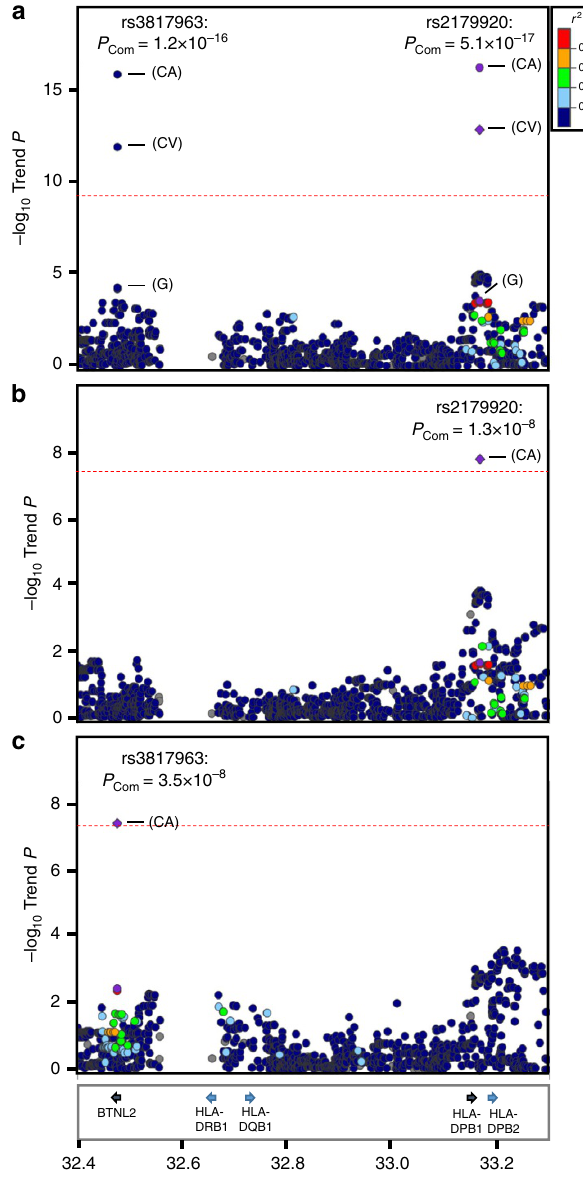
Figure 1 | Regional plots of variations in the HLA class II region. Plots show results of association studies of ( a ) nominal analysis, ( b ) conditioned analysis on rs3817963 and ( c ) conditioned analysis on rs2179920. Red line shows the level of genome-wide significance for association ( P Trend o 5 (cid:2) 10 (cid:3) 8 ). Genes within the region of interest are annotated and are indicated by arrows. The physical positions of the variants in the HLA class II region are shown at the bottom. Circles represent the location and –log 10 ( P Trend values) of each variant. The –log 10 P Trend values of the marker SNPs are shown for the GWAS (G), the combined validation study (CV) and the total combined study (CA).